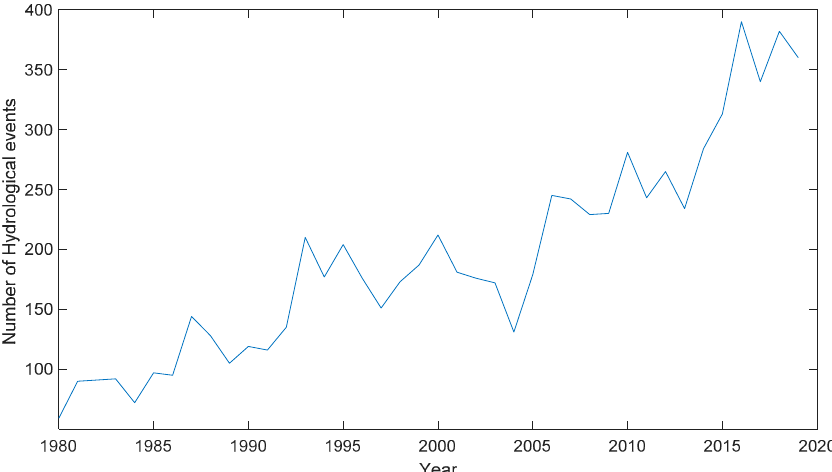
Figure 1. Number of Hydrological events causing peril 1980–2019 (https://www.muni- chre.com/en/risks/natural-disasters-losses-are-trending-upwards/hurricanes-typhoons-cy- risks/natural-disasters-losses-are-trending-upwards/hurricanes-typhoons-cyclones.html, clones.html, accessed on 27 October 2020).